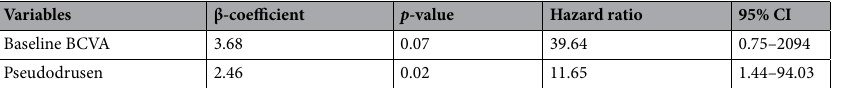
Table 5. Cox regression analyses associated with atrophy (repeated forward selection method). Age, Sex, drusenoid pigment epithelial detachment, hyperreflective foci, baseline subfoveal choroidal thickness, ARMS2 A69S, and CFH I62V were eliminated in this analysis. BCVA, best-corrected visual acuity.